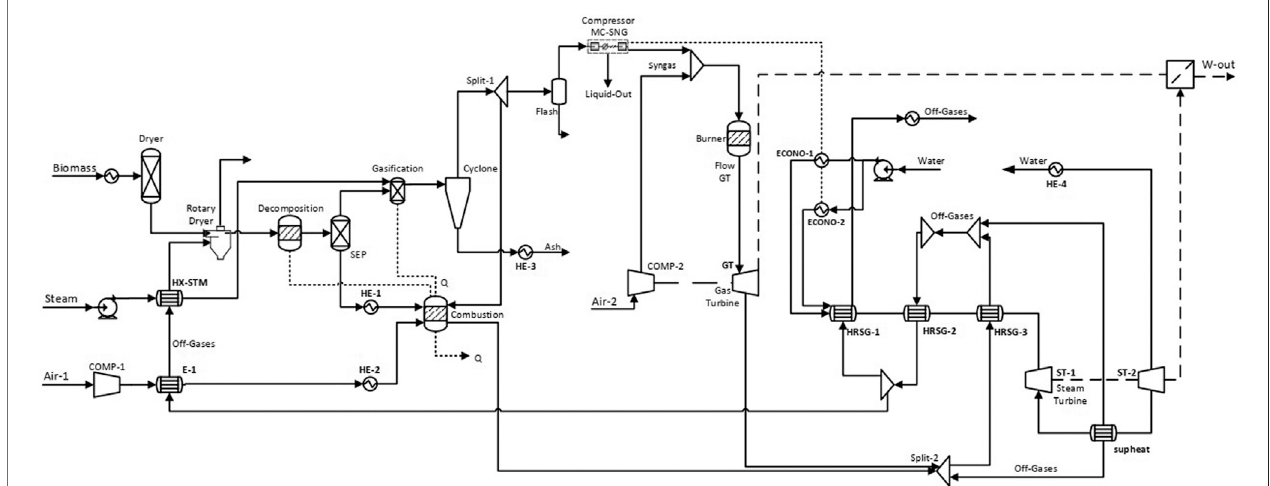
FIGURE 2 | Dual fl uidized bed